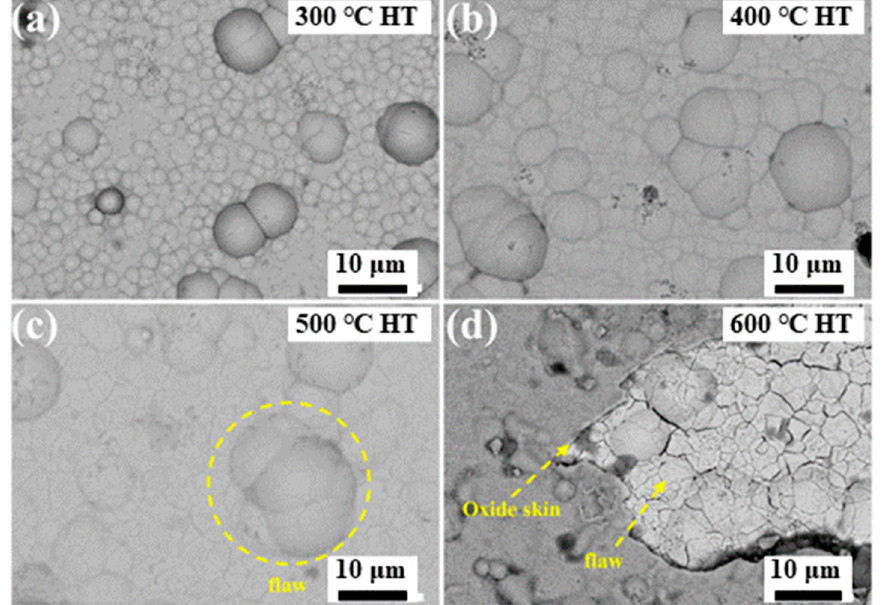
Figure 9. Surface morphology of the Ni-P-CS coating after heat treatment at different temperatures. ( a ) 300 °C Heat Treatment, ( b ) 400 °C Heat Treatment, ( c ) 500 °C Heat Treatment, ( d )600 °C Heat Treatment.